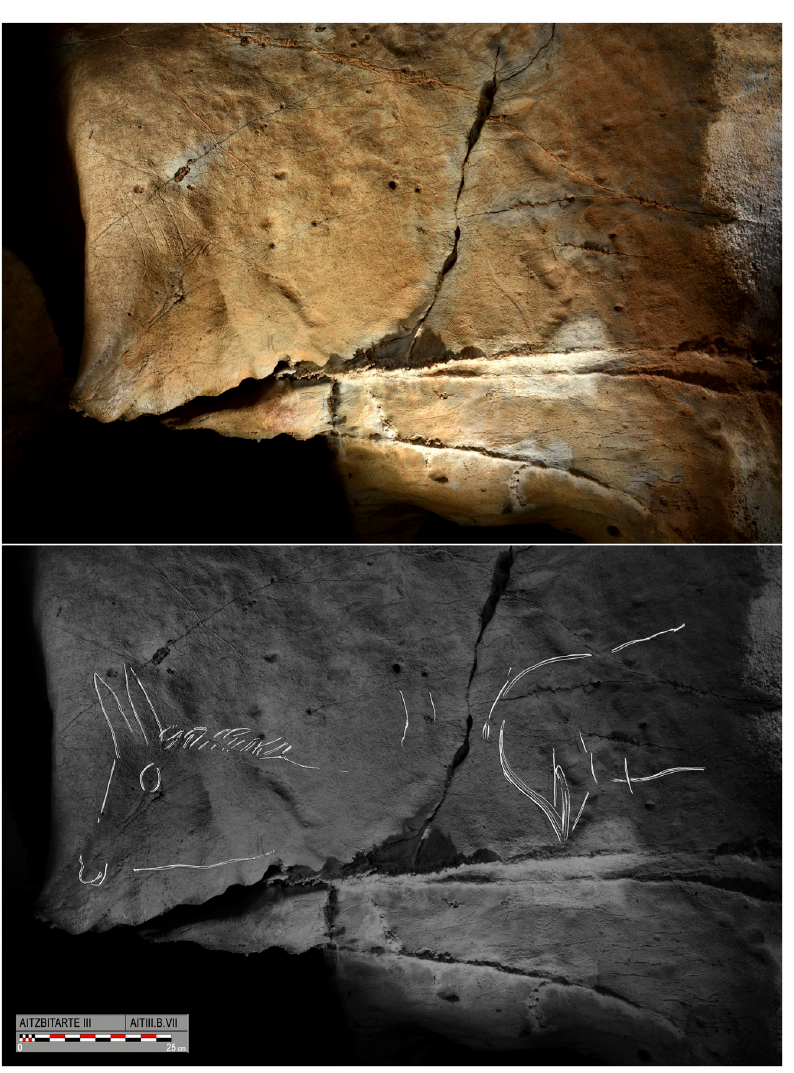
Fig 7. Photograph and tracing on panel B.VII at the bottom of the ramp in Aitzbitarte III: Indeterminate animal B.VII.1; bovid horns B.VII.2; and horse fore-quarters B.VII.3 (O. Rivero and D. Garate).